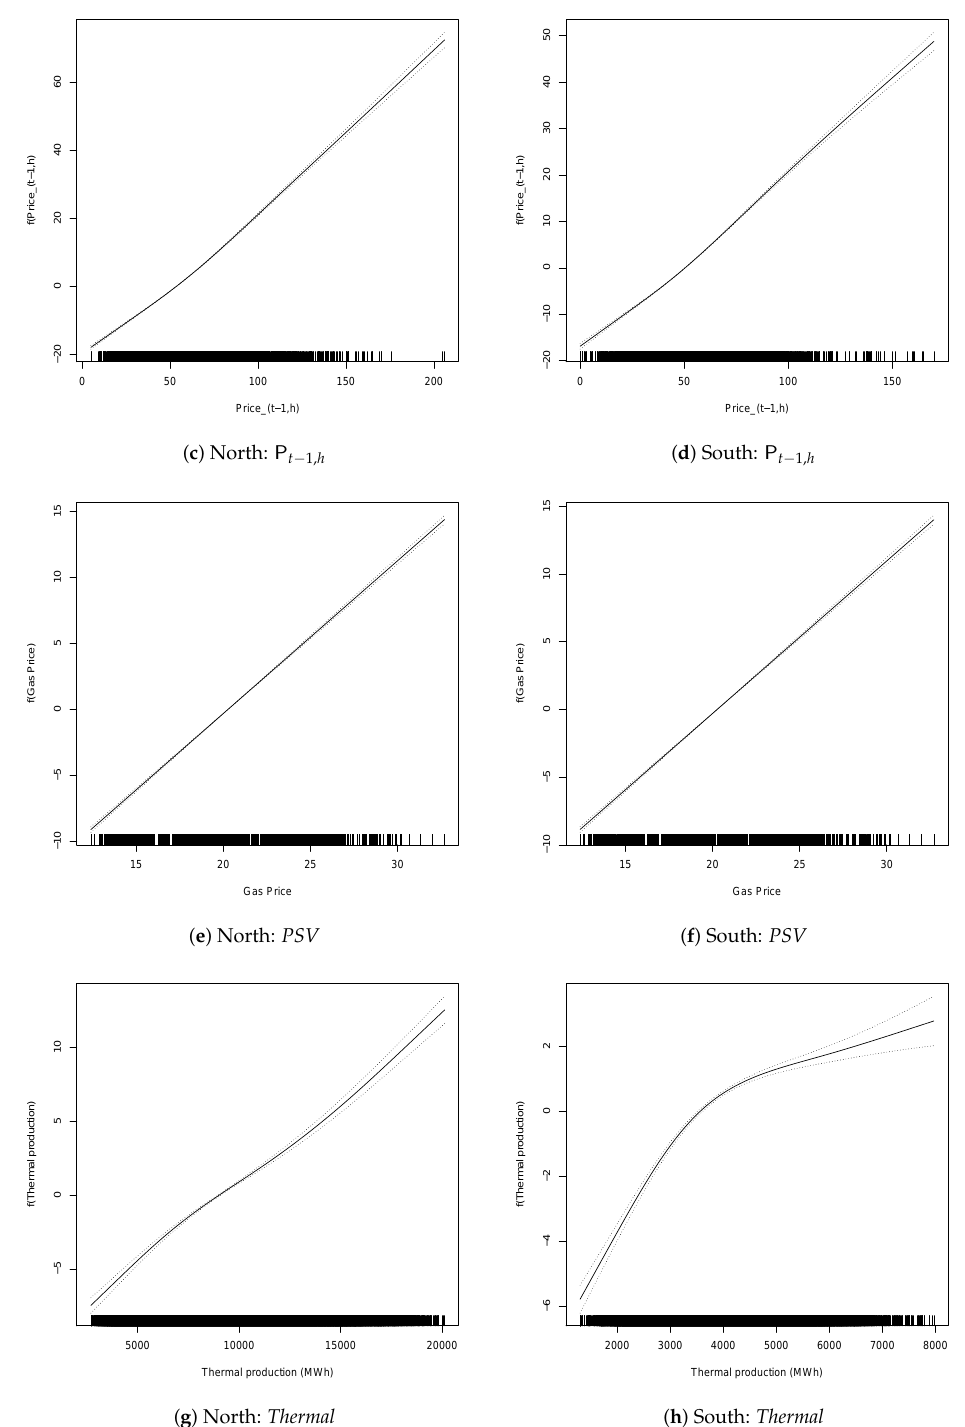
Figure 3. In-sample estimation results of the non-parametric additive model for the conditional mean of electricity prices. For both zones, each panel plots the estimated function f j ( · ) for the prices, demand and thermal